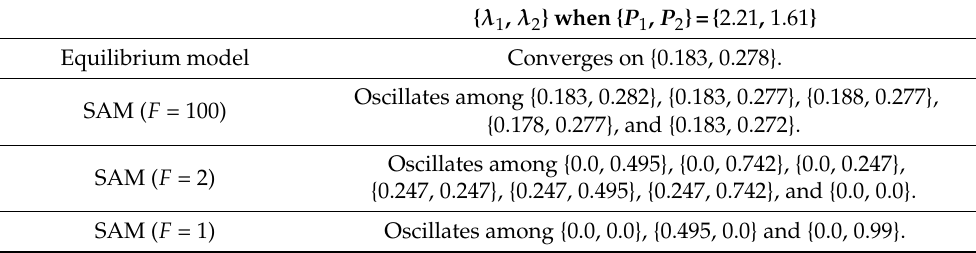
Table 5. Case III comparison results.